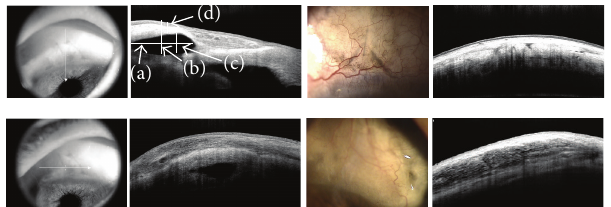
Figure 12: Anterior segment OCT images after trabeculectomies. Vertical and horizontal OCT sections (left column) demonstrate various parameters: internal cavity extent (a), bleb height (b), internal cavity height (c), and bleb wall thickness (d). Right upper images demonstrate thick bleb wall and high internal reflectivity suggesting bleb failure. Right lower images demonstrate relatively thin bleb wall and multiple- layer appearance with low internal reflectivity with good IOP control.